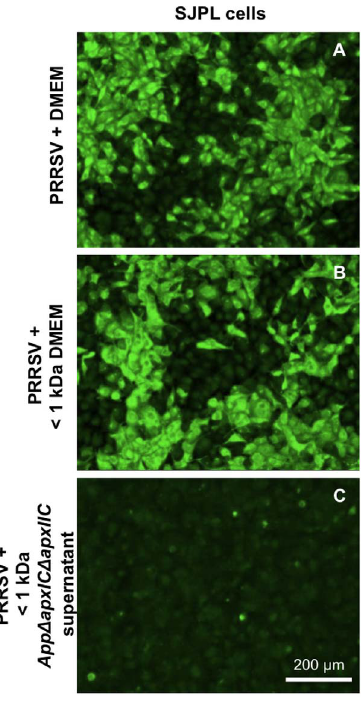
Figure 5. App D apxI D apxIIC cell culture supernatant , 1 kDa fraction antiviral activity against PRRSV. Detection of the N viral protein in PRRSV infected SJPL cells by immunofluorescence. SJPL cells were infected with 0.5 MOI of PRRSV for 4 hours then incubated with DMEM culture medium alone (DMEM) (A) or either a DMEM culture medium fraction of , 1 kDa (DMEM , 1 kDa) (B) or a App D apxI D apxIIC cell culture supernatant , 1 kDa fraction ( App , 1 kDa) (C) added to complete SJPL culture medium for 48 hours. White scale bar represents 200 m m. Pictures were taken at 100X magnification.